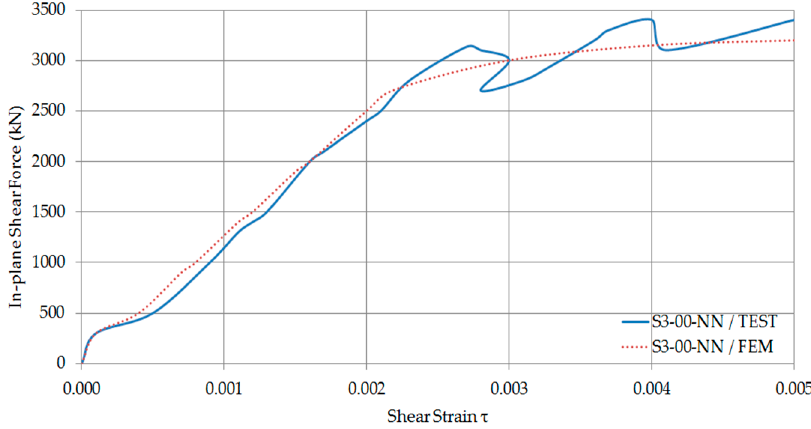
Figure 15. In-plane shear force—Shear strain Curves of S3-00-NN.